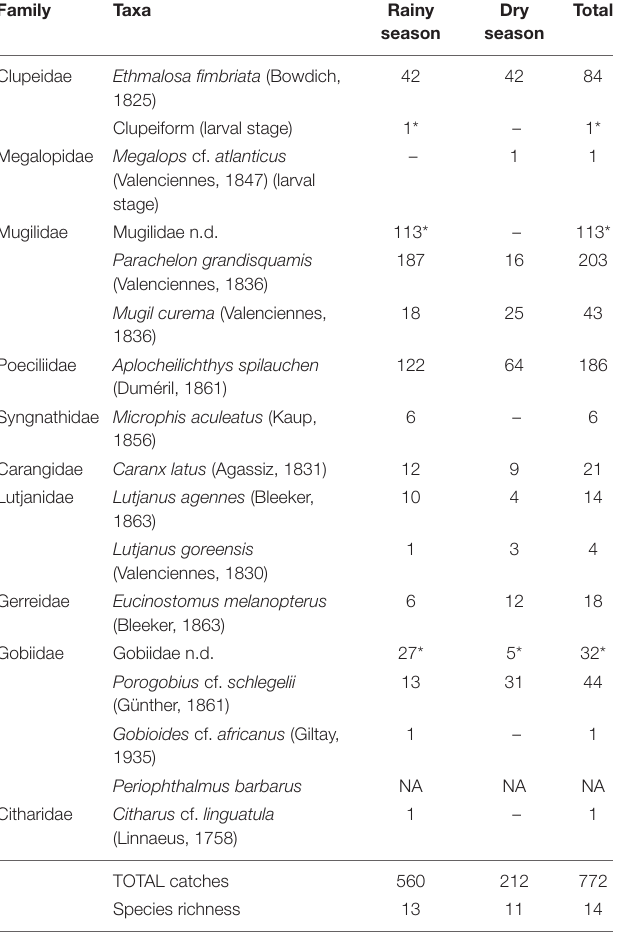
TABLE 1 | Fish taxa, respective number of specimens caught, and species richness (number of species) according to the season.